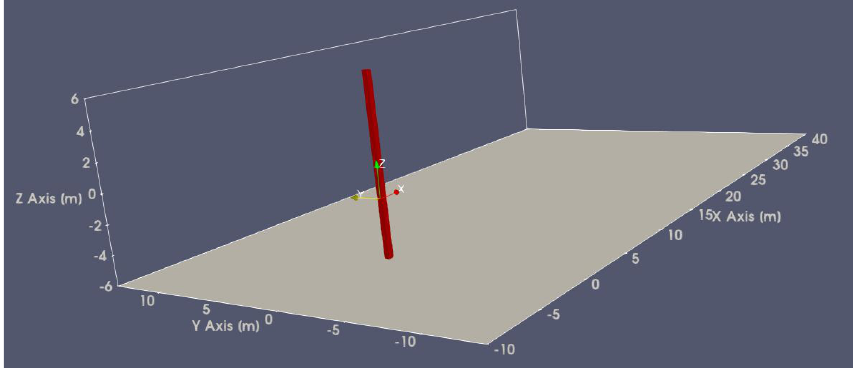
Figure 1. Sketch of the problem under investigation and numerical domain.